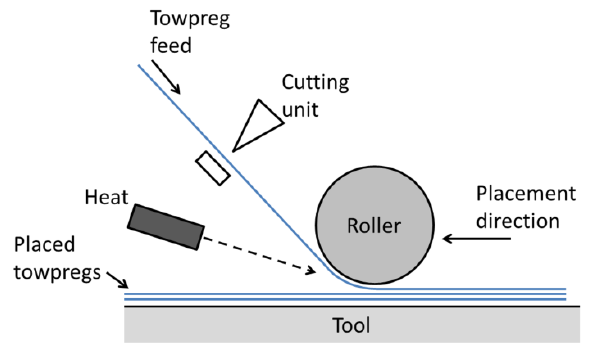
Figure 1. Schematic of the automated fiber placement process